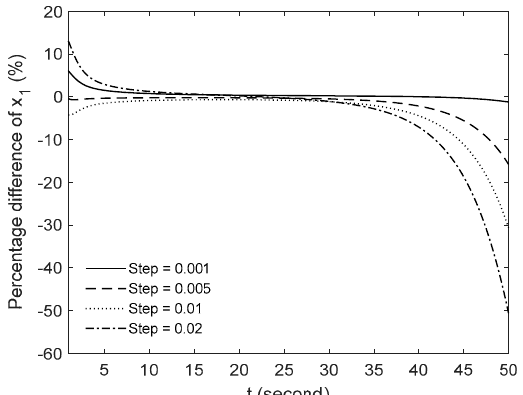
Figure 3. Percentage difference of x 1 between the exact solutions and the present method for different time steps h .